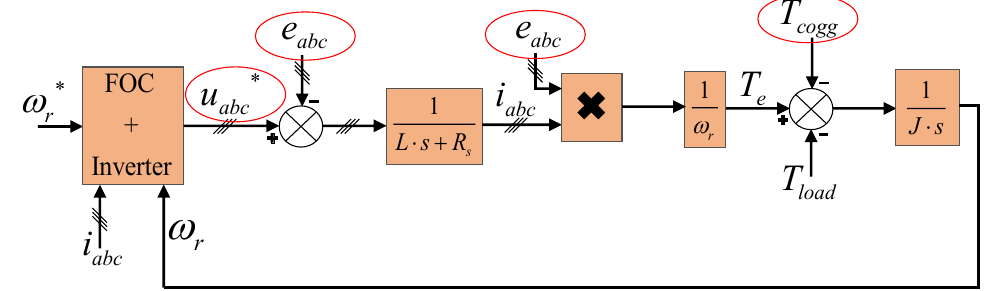
Figure 3. Fundamentals of torque ripple in PMSM controlled by